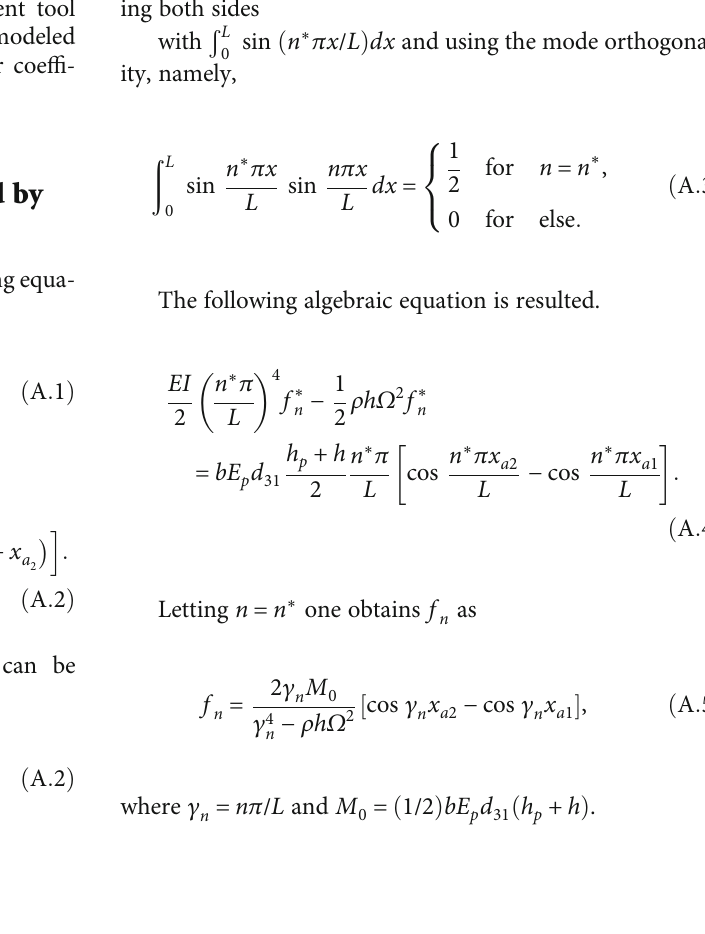
Figure 19: Time-space normalized de fl ection of S-S beam subjected to Symmetric triangular piezoelectric impulse for t ð 0 : 6,0 : 9 Þ